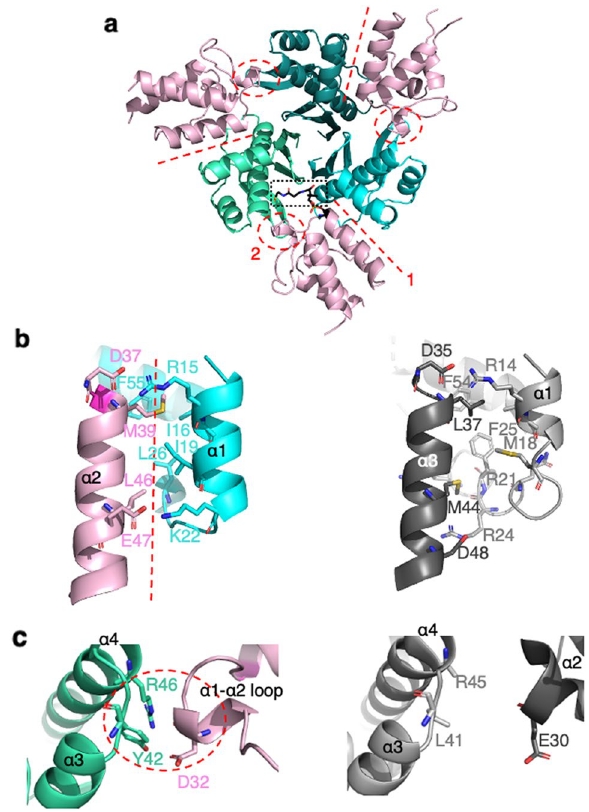
Figure 2. The L. plantarum AcpS-DltC1 complex structure. ( a ) Cartoon representation of the L. plantarum AcpS-DltC1 3D structure with the 3-branch AcpS star shown as a cyan-green color gradient and the DltC1 molecules in pink. The Ppant cofactor bound to one DltC1 molecule is shown as black sticks and highlighted by a black dashed-rectangle. The main contact surfaces, 1 and 2 are depicted as red dashed line and circle respectively. ( b ) Close-up on the contact surface 1. The interacting residues are shown in stick. Comparison between L. plantarum (left—AcpS in blue and DltC1 in pink) and B. subtilis (right—AcpS in light grey and DltC in dark grey—PDB entry 1F80) complex structures. ( c ) Close-up on the contact surface 2. The interacting residues are shown in stick. Comparison between L. plantarum (left—AcpS in green and DltC1 in pink) and B. subtilis (right—AcpS in light grey and DltC in dark